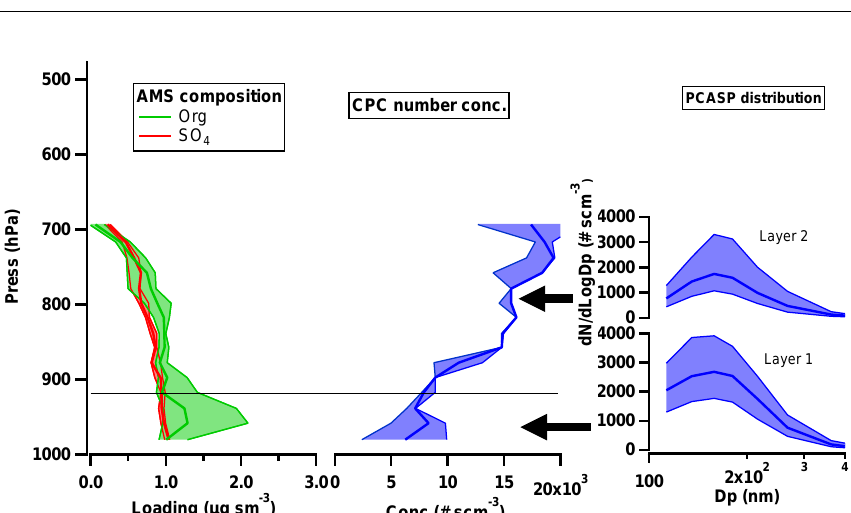
Fig. 9. Average altitude profile (median and interquartile ranges) during a period of cumulonimbus activity over East Sabah of organic and sulphate aerosol loading, number concentration and number/size distributions for each layer. Data only exists below exists below 700hPa. Averages of two profiles on 13 July 2008.